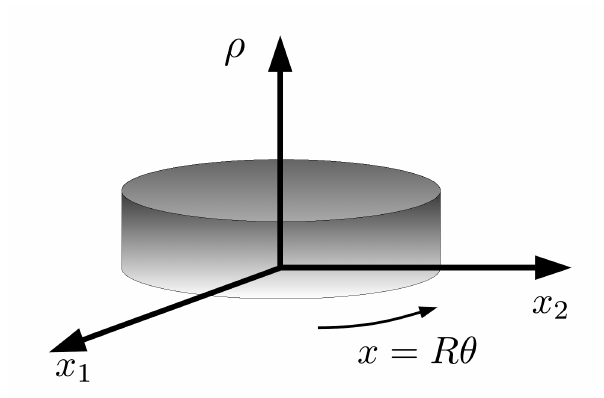
Figure 4: Ground-state electron density (43) in the geometry of the disk with radius R ; the coordinate along the edge is x = R θ